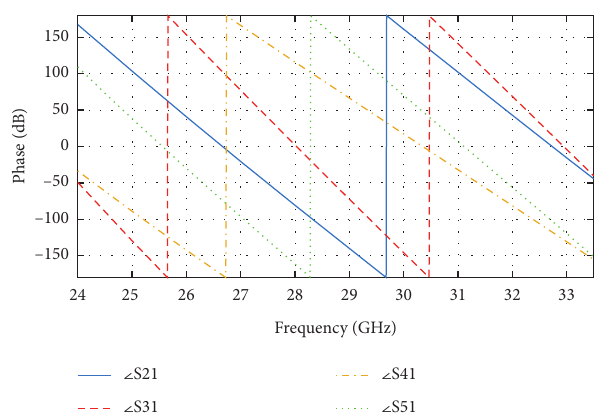
Figure 6: Simulated phase of the sequential-phase feeding network output ports.